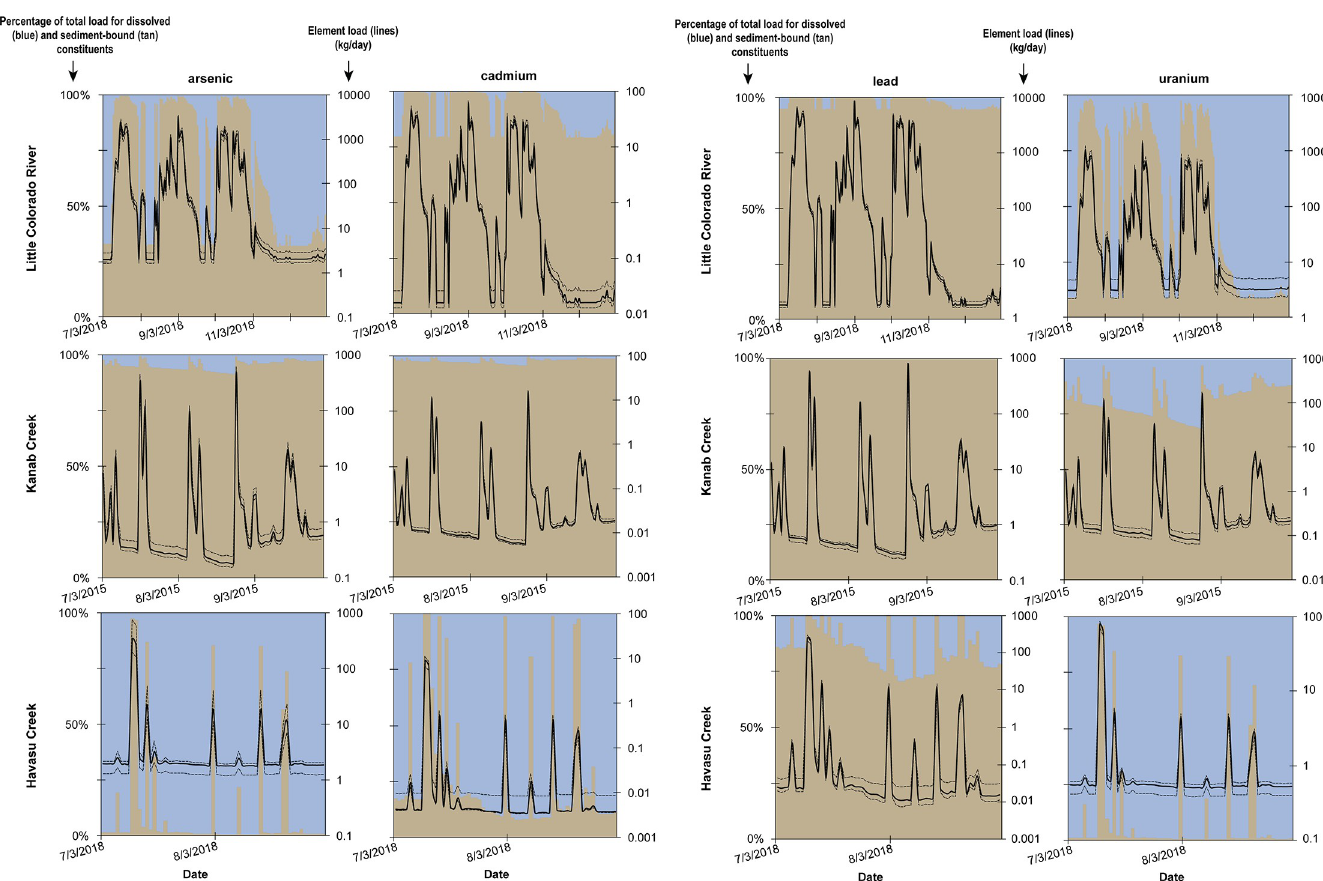
Fig 11. Dissolved and suspended-sediment-bound percentage, and estimates of the total load of arsenic, cadmium, lead, and uranium from the Little Colorado River, Kanab Creek, and Havasu Creek tributary sites during select time periods. Blue and tan areas represent dissolved and suspended-sediment-associated percentages (left axis), respectively. Solid line is total load (right axis) estimated with median concentration values while dashed lines used interquartile range of concentrations to illustrate